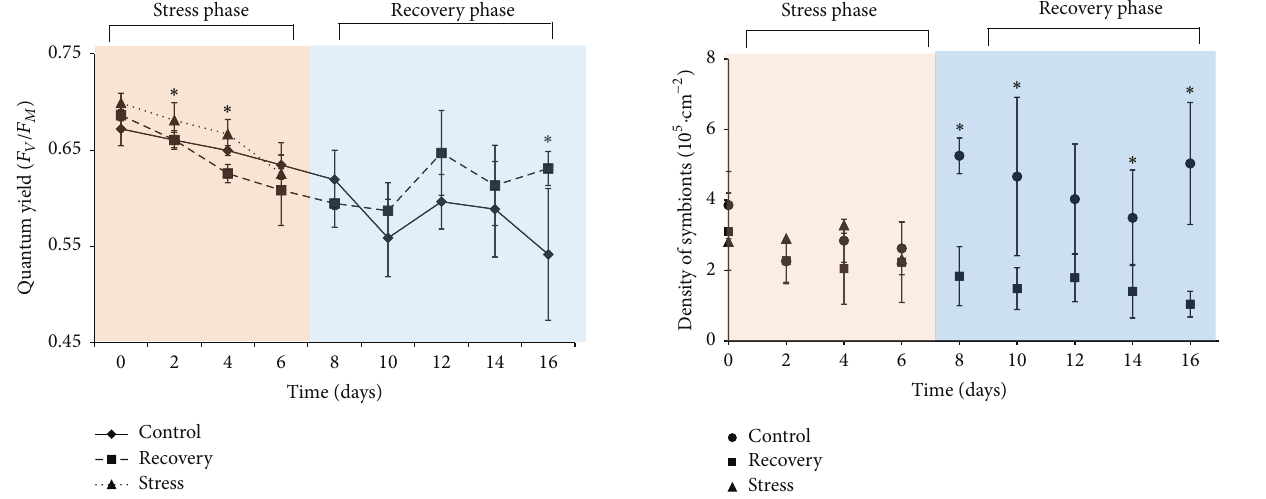
Figure 6: Symbiodinium densities in living tissue of Pocillopora damicornis coral fragments ( 𝑛 = 3 ) in control (26 ∘ C); recovery treatment (ramping from 26 ∘ C at day 0 to 32 ∘ C at day 6 then cooling to 26 ∘ at day 9); and stress treatment (ramping from 26 ∘ C at day 0 to 32 ∘ C at day 6 and then stable at 32 ∘ C until day 16) during 16 days. Asterisks ( ∗ ) stand for a significant difference ( 𝑝 ≤ 0.05